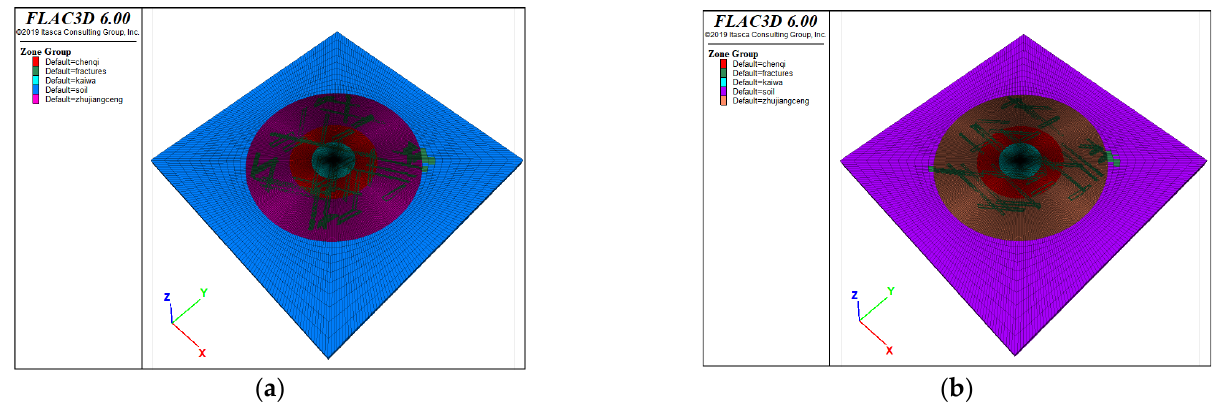
Figure 13. Dual ‐ medium model diagram of two sections. ( a ) S1ZK0 + 660 m; ( b ) S1ZK0 + 735 m. According to the dual medium model established above, the actual hydrostatic pressure outside the grouting ring was used as the boundary condition. By changing the random seed, the osmotic pressure formed by the groundwater reduction through the grouting circle under different fracture conditions was simulated. By setting four water pressure monitoring points in the four directions of the model, the layout of the measuring points was the same as that of the monitoring scheme (as shown in Figure 7, water pressure on the outside of the lining). The monitoring results are shown in Figure 14.